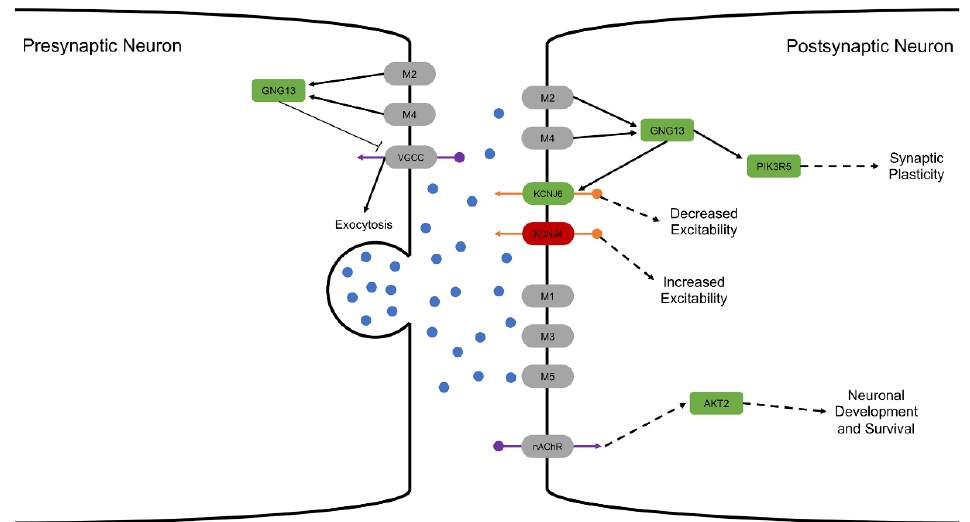
Figure 6. Altered methylation of genes in the cholinergic synapse pathway. Depiction of genes involved in cholinergic signaling. Green represents genes hypermethylated in the reduced cognition group, red represents genes hypomethylated in the reduced cognition group, and grey represents genes without di ff erential methylation. Blue circles represent acetylcholine, orange circles represent potassium, and purple circles represent calcium.